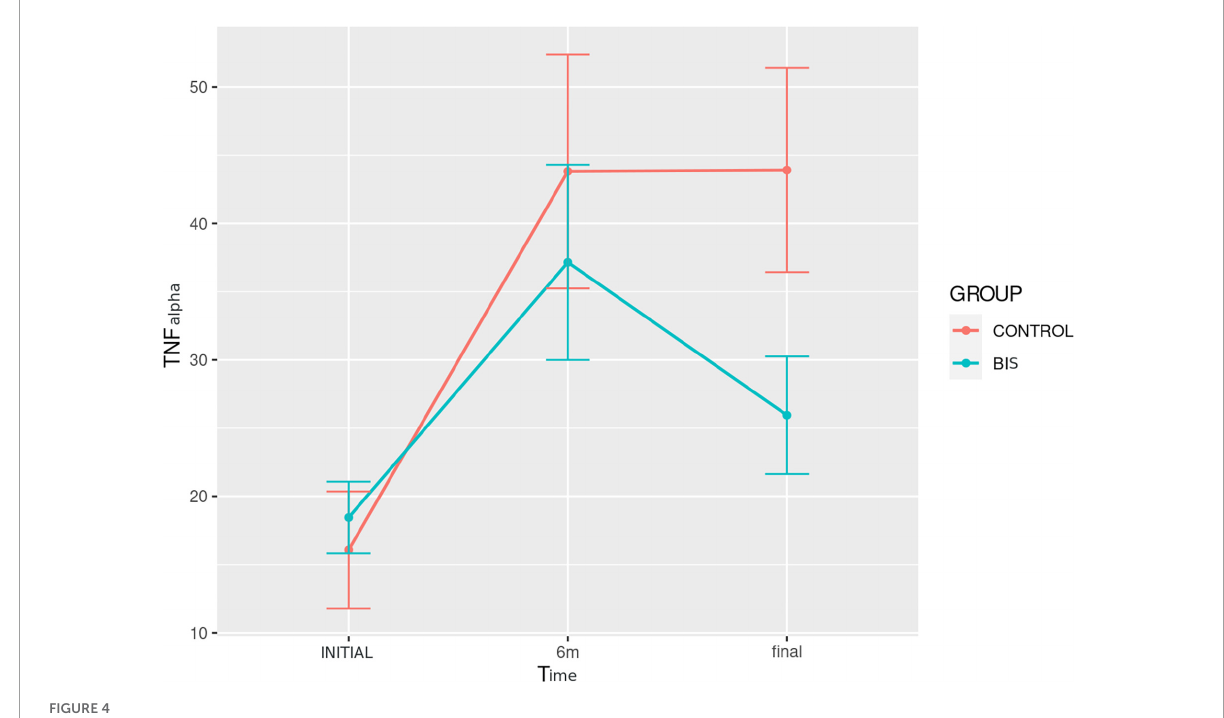
FIGURE4 Evolution of TNF- α concentration over time in the study groups.